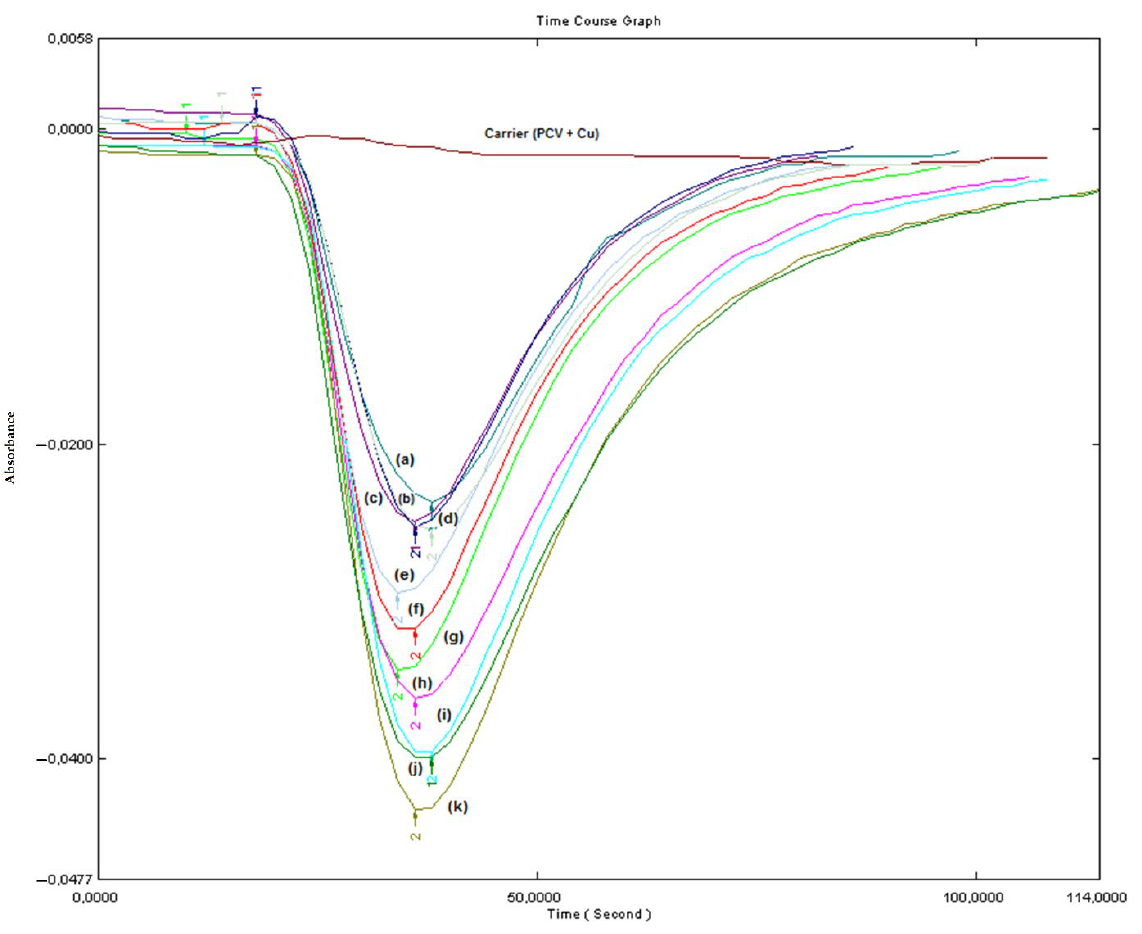
Figure 9. Typical flow injection signals for the determination of CTAB. Concentration of CTAB (µg mL −1 ), (a) 0.0, (b) 2.5, (c) 5.0, (d) 10, (e) 20, (f) 30, (g) 40, (h) 60, (i) 80, (j) 90, (k) 100. The Cu-PCV carrier solution (1.0 mmol L −1 each), sample loop 200 µL, carrier flow rate 3.5 mL min −1 , and measurement at 430 nm.